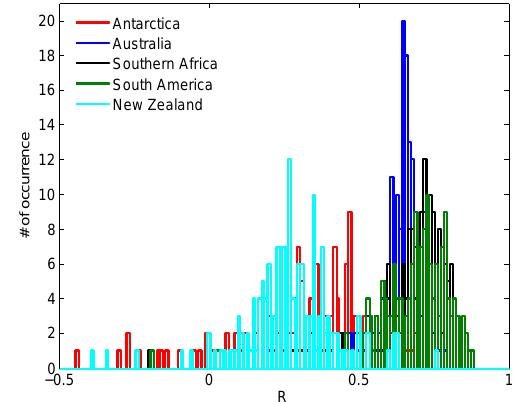
Fig. 8. Histogram of the correlation coefficient R of the REE pattern of each sample between 26500 and 15200yrBP and the mean REE pattern of each PSA (red: exposed areas in Antarctica, green: South America, blue: south eastern Australia, black: southern Africa, light blue: New Zealand). Each ice sample from the glacial stage was correlated with the mean value from each PSA. Thus, for each PSA 165 values for R were calculated, which are plotted here. For this calculation the crust-normalized values were used according to Eq. (2).